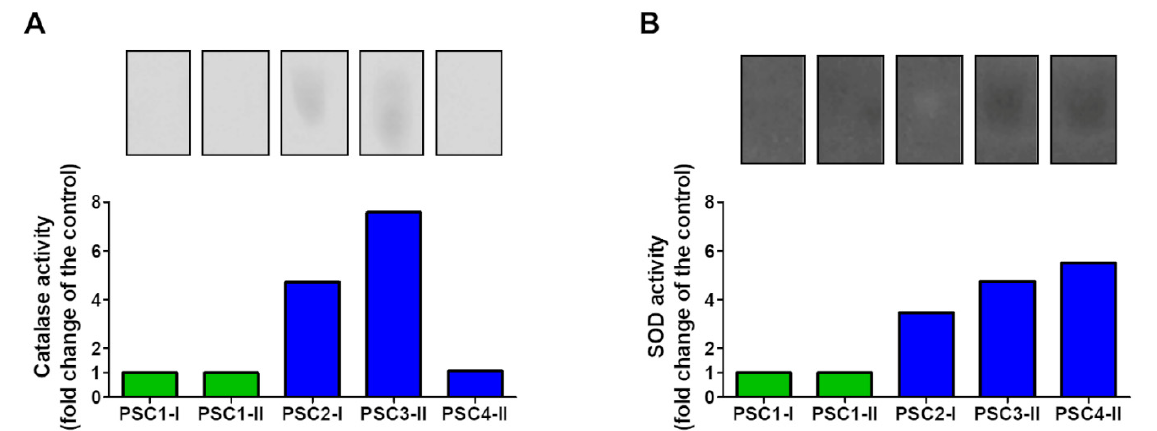
Figure 2. Biochemical properties of the PSC2-I, PSC3-II, and PSC4-II extracts compared to the control (PSC1-I for PSC2-I, and PSC1-II for PSC3-II and PSC4-II): activity of catalase ( A ) and SOD ( B ).